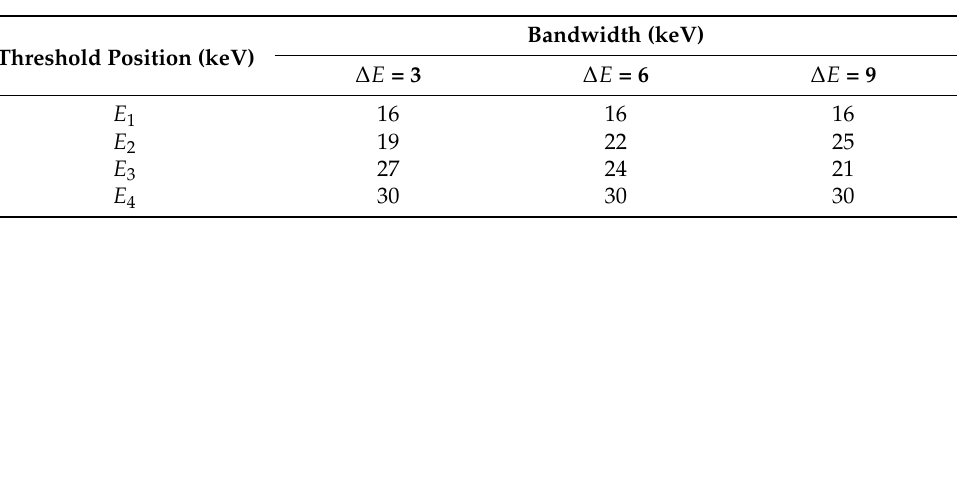
Figure 3. Workflow for obtaining the separate thickness of the epoxy and HA400 components using a simulated test phantom. The distance along the X -axis of the plots corresponds to the X -axis direction in Figure 2. Table 2. Simulation parameters used for the four energies thresholds E 1 , E 2 , E 3 and E 4 to obtain three pairs of different energy